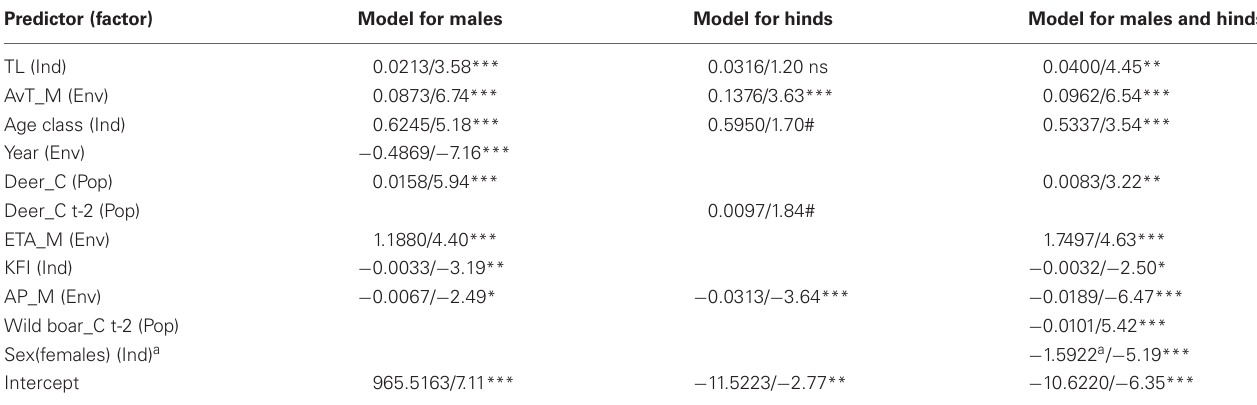
Table 5 | Statistical parameters (coefficient/test-value and significance: ns: non-significant, #0.1, ∗ 0.05, ∗∗ 0.01, and ∗∗∗ 0.001) of the generalized lineal models (negative binomial error distribution and logarithmic link function) carried out to predict tick burden on red deer. Predictor (factor)